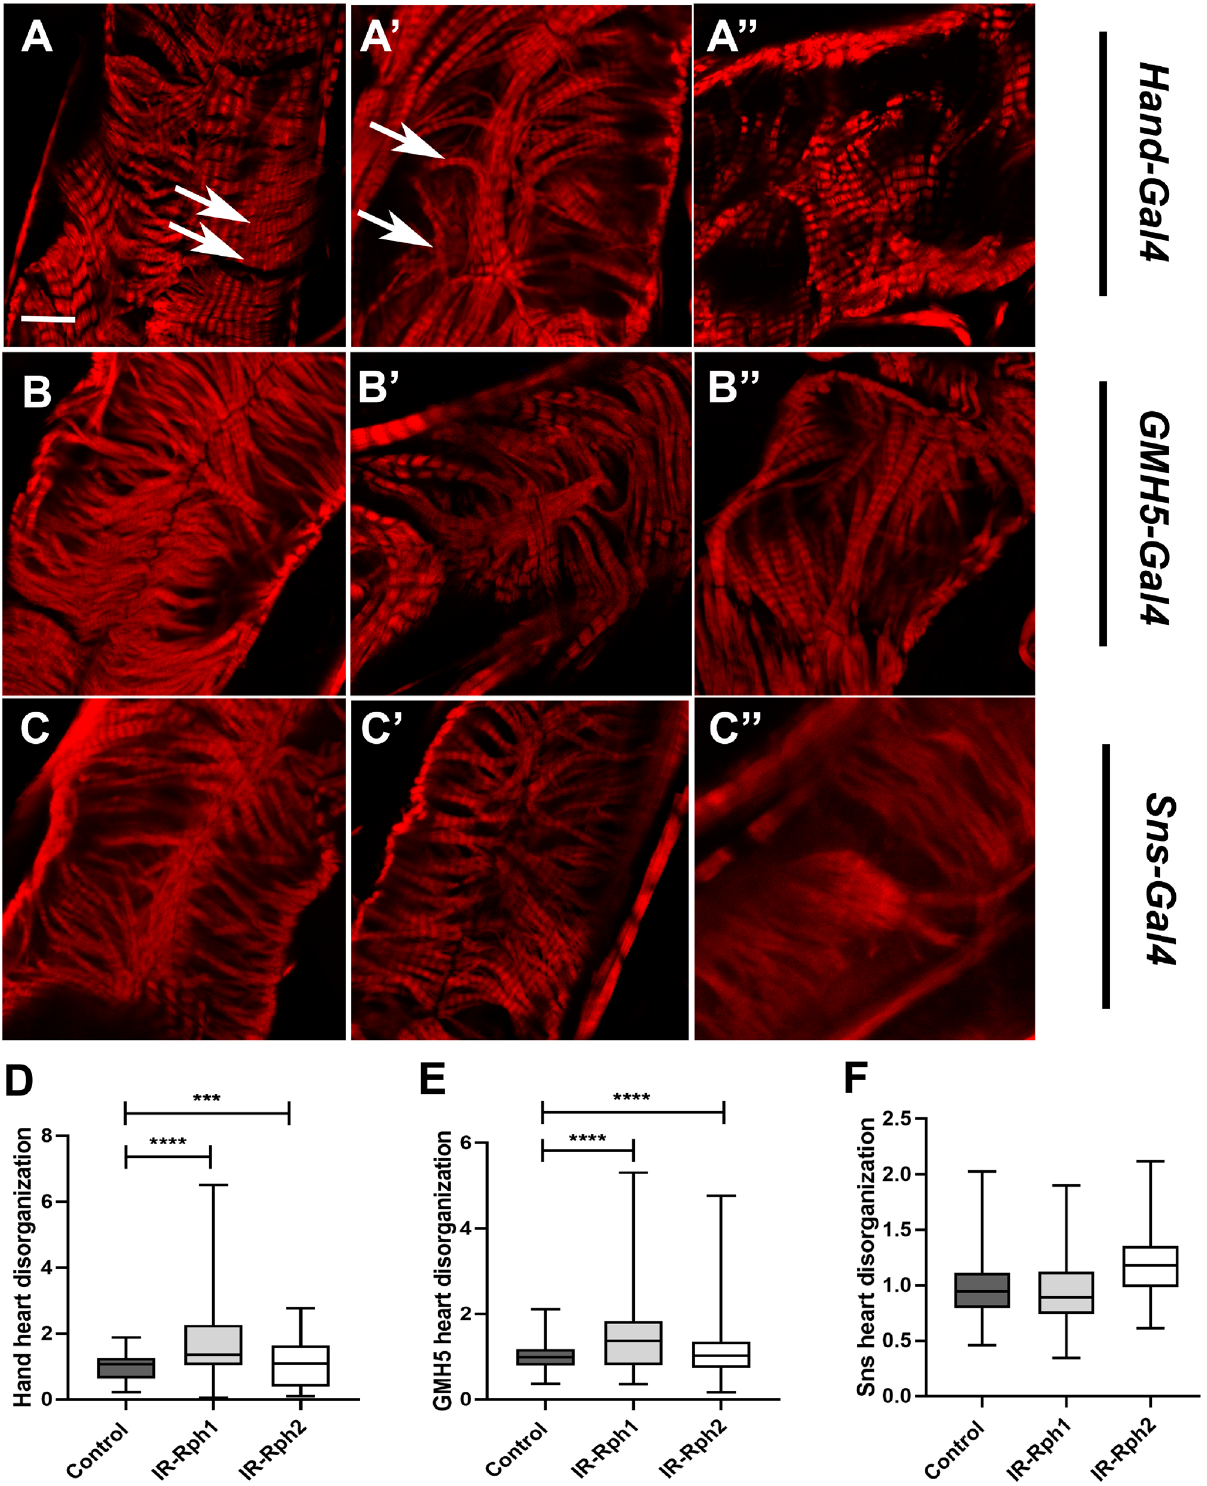
Figure 3. Rph interference in the heart promotes disruption of the disposition of circumferential myofibrils. Heart confocal images from the A1 segment (conical chamber) under the control of Hand-Gal4 ( A–A ″ , D ), GMH5-Gal4 ( B–B ″ , E ) or Sns-Gal4 driver ( C–C ″ , F ). Phalloidin (red) stains actin fibers (arrow) in Drosophila heart tubes. The interference of Rph expression line 1, IR-Rph1 ( B ′ , C ′ ) and interference of Rph line 2, IR-Rph2 ( B ″ , C ″ ) in cardiomyocytes causes disorganization of actin fibers (arrow), but it does not affect flies with low Rph levels only in pericardial nephrocytes ( C–C ″ , F ). ( D – F ) Display the quantification of fibers disorganization. Genotypes of the control flies are Hand-Gal4 UAS-GFP > yw, GMH5-Gal4 UAS-GFP > yw and Sns-Gal4 UAS- GFP > yw. Scale bar = 10 µm. Bartlett’s test, *** p value < 0.001, **** p value <